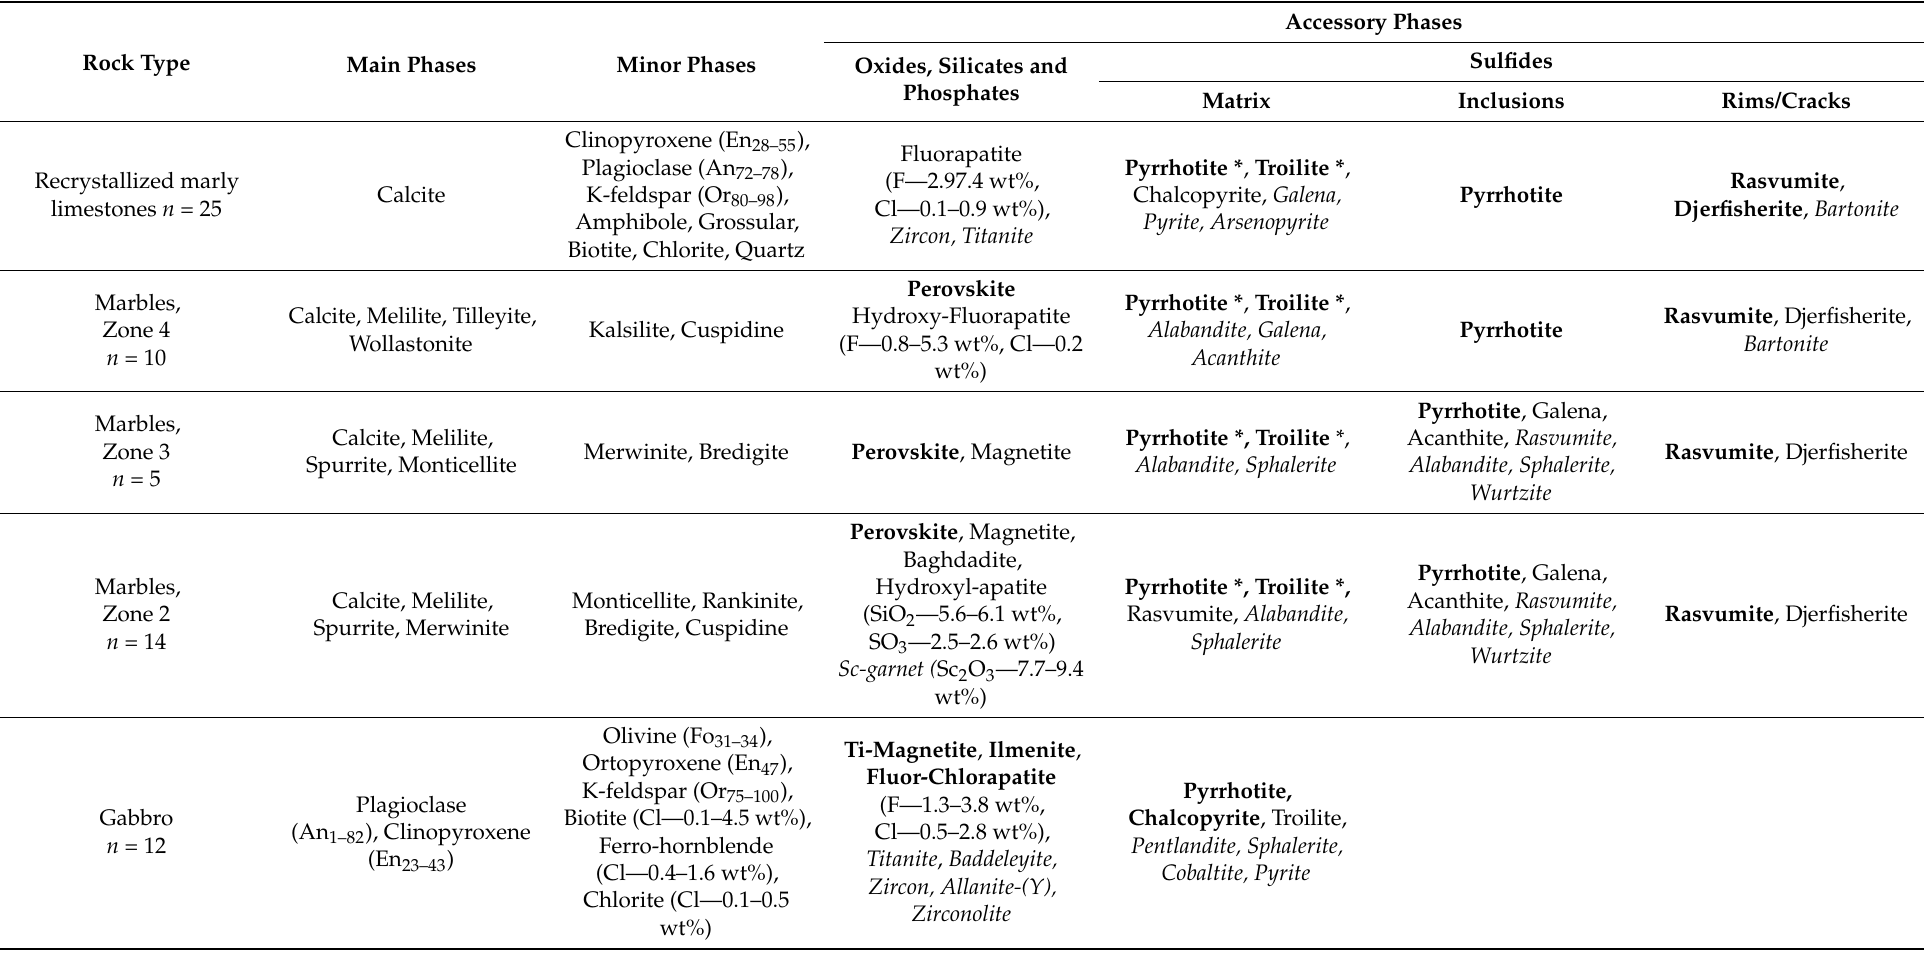
Table 2. Mineral assemblages of recrystallized marly limestones, marbles and gabbro from the Kochumdek contact aureole (XRD, SEM-EDS, and EPMA